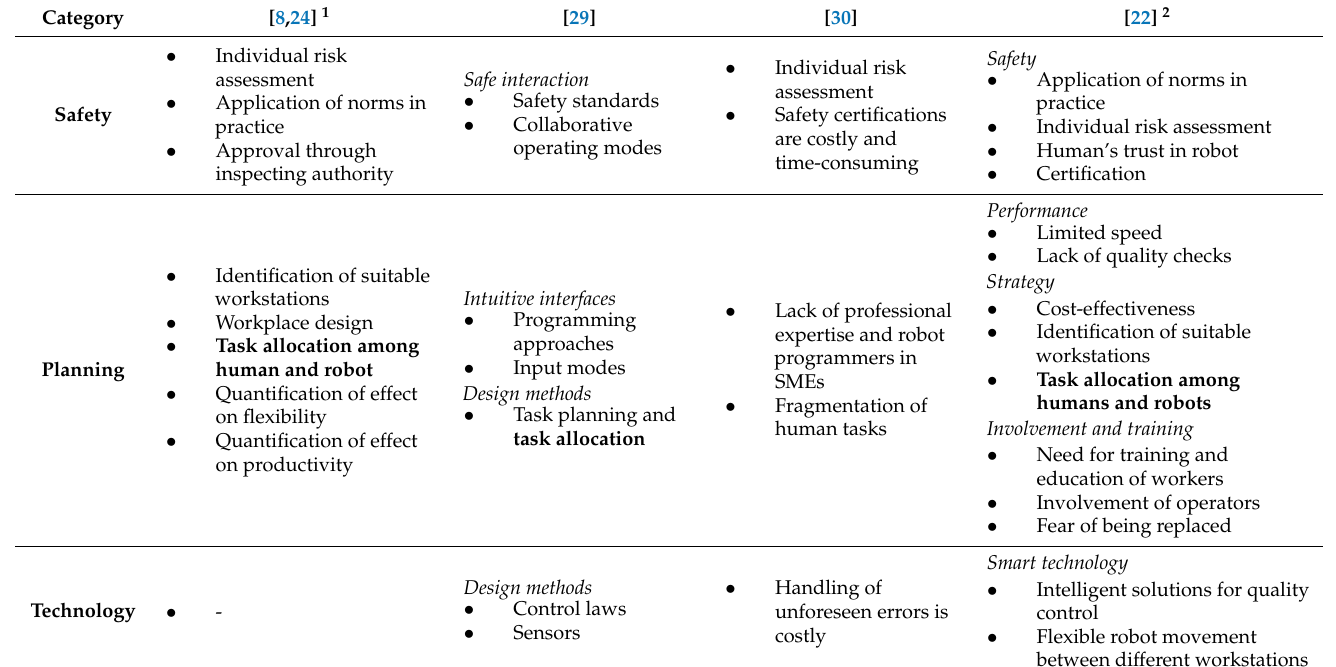
Table 1. Key challenges in human–robot collaboration (HRC) identified in the literature and grouped into three categories: safety, planning, and technology. The original categories of challenges proposed by the respective references are indicated in italics. The challenge of task allocation is highlighted in bold in the referenced